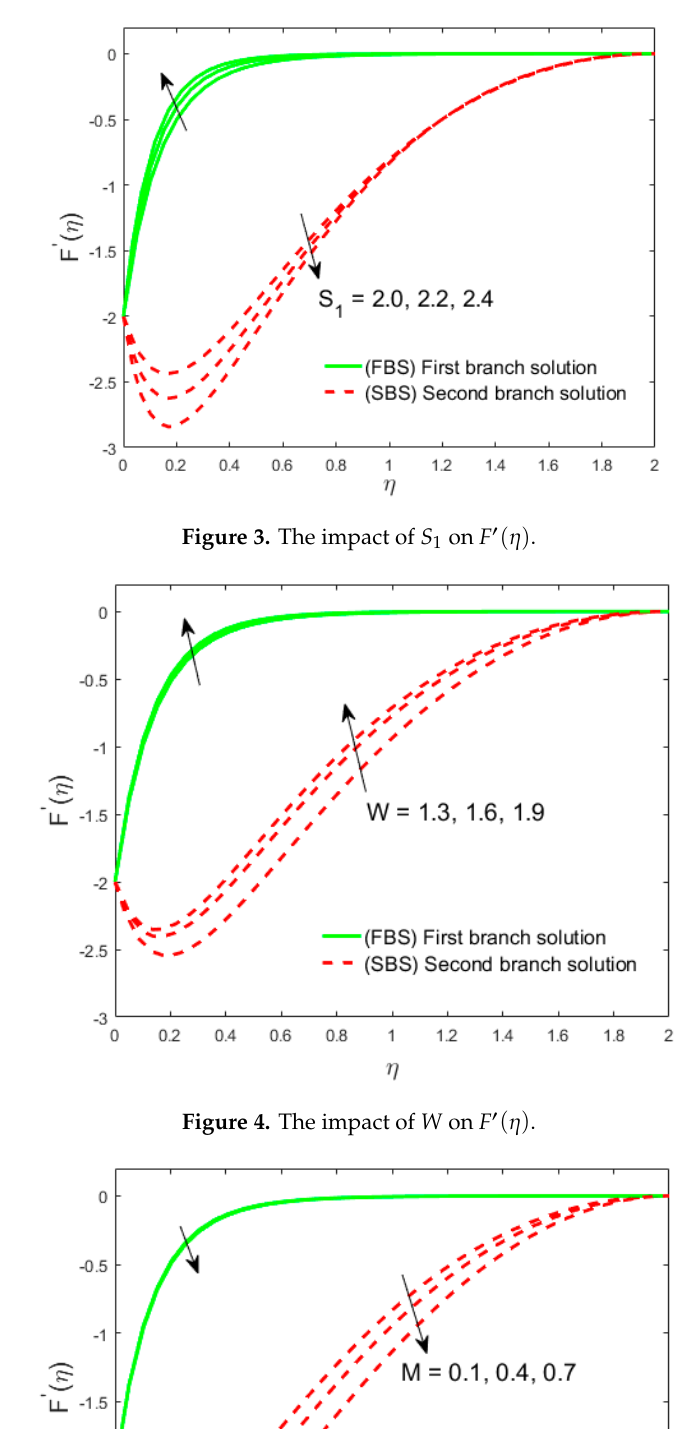
( ) ' F η . Figure 5. The impact of M on F (cid:48) ( η ) ( ) ' F η .